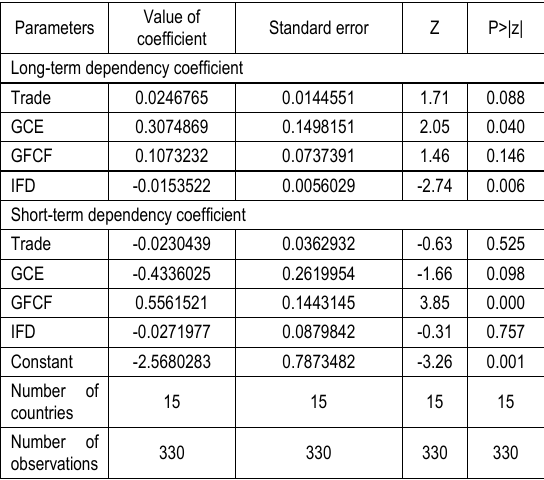
Table 7. The results of the PMG approach